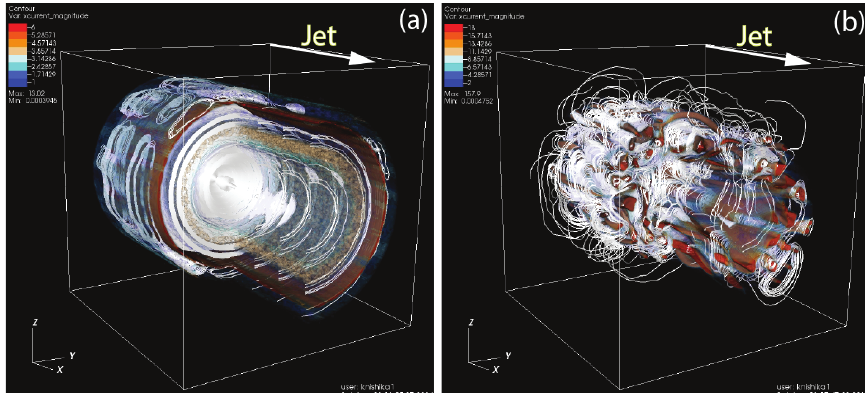
Figure 5. Isocontour plots of the J x magnitude with magnetic filed lines (one fifth of the jet size) for ( a ) an e − − p + and ( b ) an e e ± jet at simulation time t = 300 ω − 1 pe . The 3D displays are clipped both along and perpendicular to the jet in order to view the interior. Adapted from Figure 4 in Nishikawa et al.